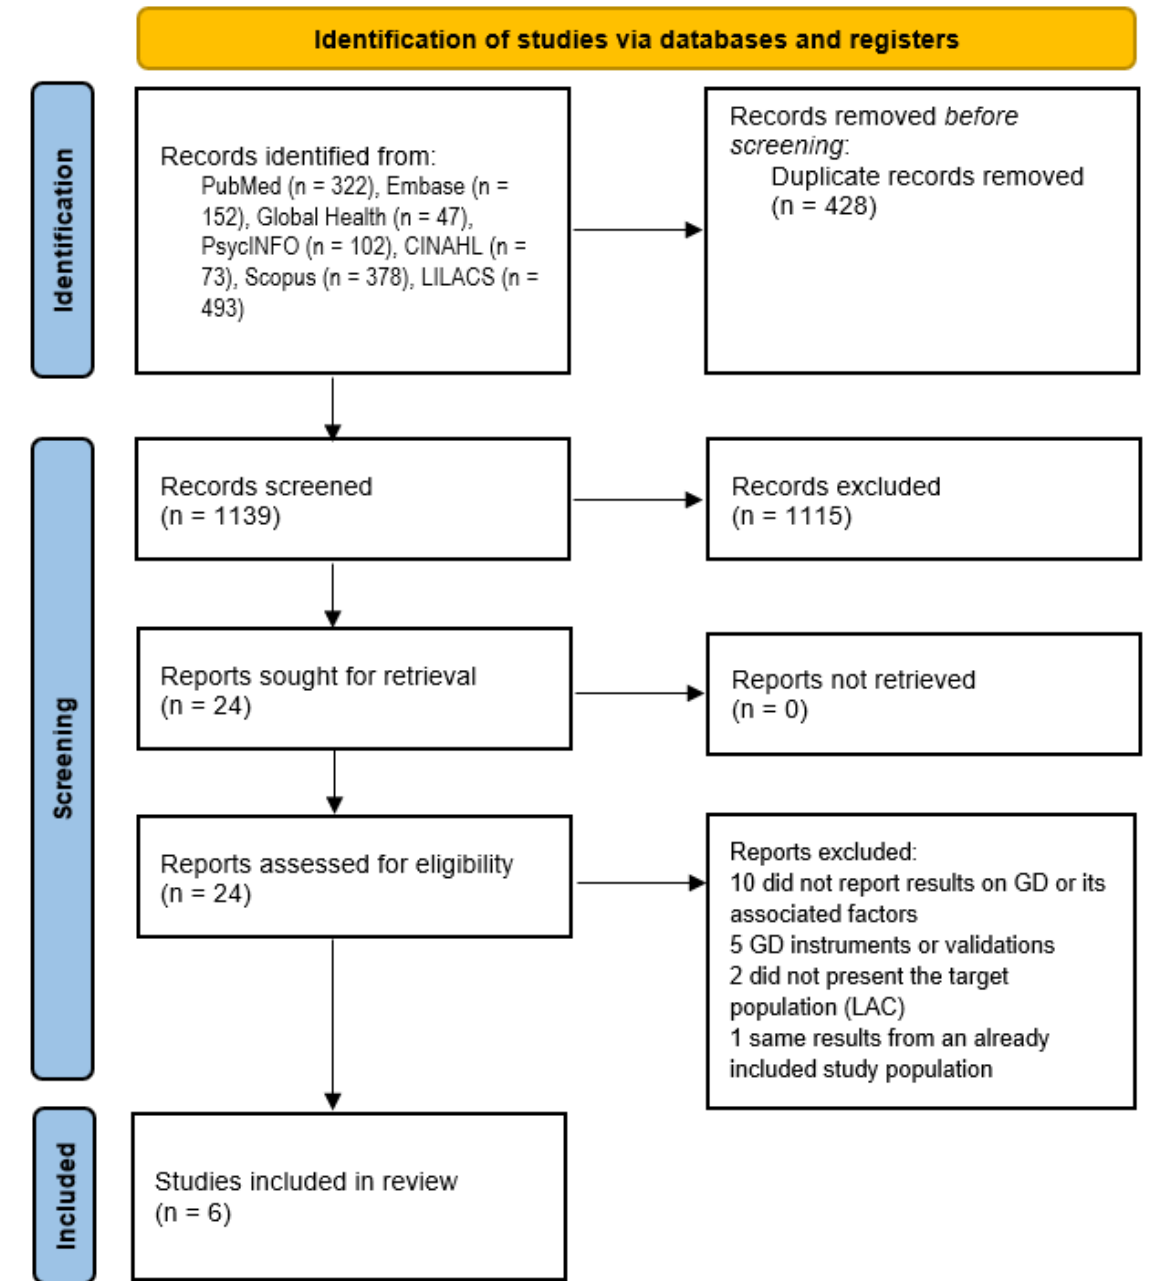
Figure 1. PRISMA 2020 Flow diagram of study selection. GD: gaming disorder, LAC Latin America and The